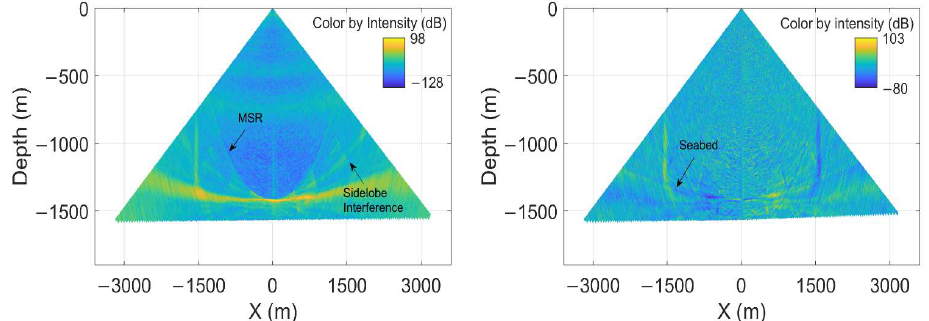
Figure 18. Symmetric subtraction results for outside